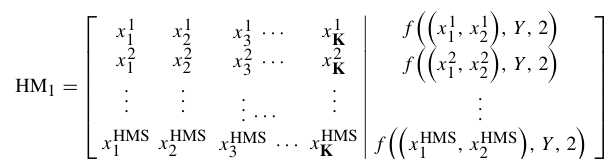
Fig. 2 Four tasks are separately employed to detect 2nd- order , 3rd- order , 4th- order and 5th- order SNP interactions simultaneously. The t -th task possesses an HM (HM t ) for recoding the potential SNP combinations and has four elite harmony sets (EHS 1 t , EHS 2 t , EHS 3 t and EHS 4 t ) for storing the elite solutions. In EHS 1 t , the association of SNP combinations is calculated with the K2 score based on a Bayesian network. The association of SNP combinations is calculated with the LR in EHS 2 t . In EHS 3 t